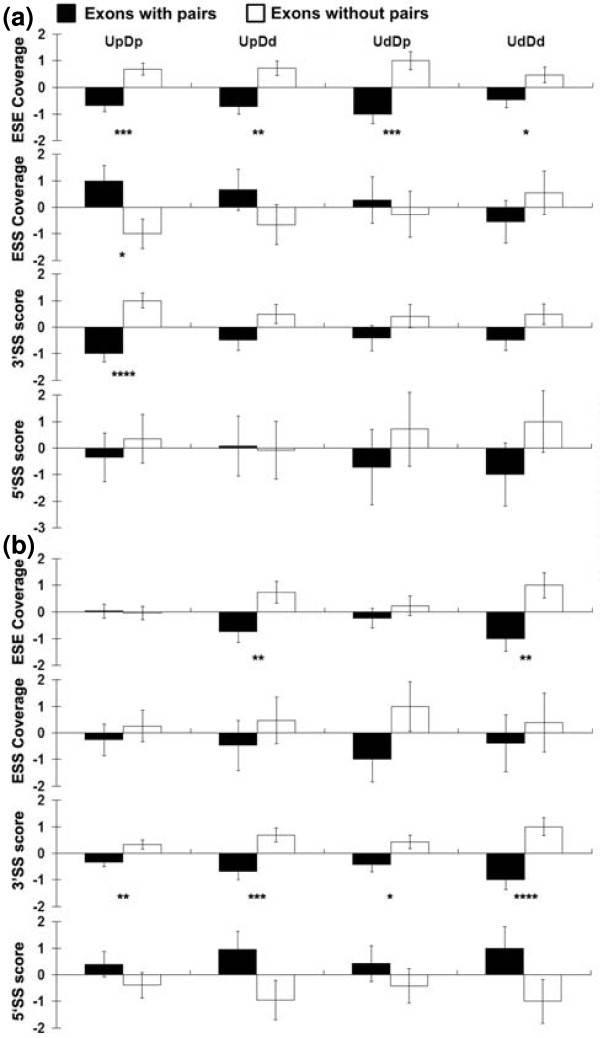
Co-occurring pairs are associated with weaker exons. (a) Two sets of constitutive exons were compared, one with co-occurring pairs in the indicated region and one without such pairs. The two sets were matched for GC content in the pertinent regions. ESE and ESS coverage refers to the proportion of exonic nucleotides that reside in a composite set of ESE and ESS hexamers [10]. 5' and 3' splice site scores are based on the method of Shapiro and Senapathy [50]. For each comparison the mean of the two exon sets was subtracted from all values to create a mean of zero and the maximum difference between the values of the two exon sets and this mean was set to 1; all other values were adjusted accordingly. All four UpDp, UpDd, UdDp, and UdDd combinations were treated separately. Error bars are the standard error of the mean. Asterisks below the bars indicate P-values: *P < 0.05; **P < 0.001; ***P < 0.0001; ****P < 0.00001. SS, splice site. The range of actual values across all four regional comparisons were: ESE coverage, 0.439 to 0.467; ESS coverage, 0.109 to 0.125; 3' splice site scores, 74.295 to 75.514; 5' splice site scores, 81.519 to 82.124. (b) As (a), but two sets of alternatively spliced exons were compared, one with co-occurring pairs in the indicated region and one without such pairs. The range of actual values across all four regional comparisons were: ESE coverage, 0.393 to 0.432; ESS coverage, 0.092 to 0.109; 3' splice site scores, 68.676 to 71.780; 5' splice site scores, 78.914 to 80.087.